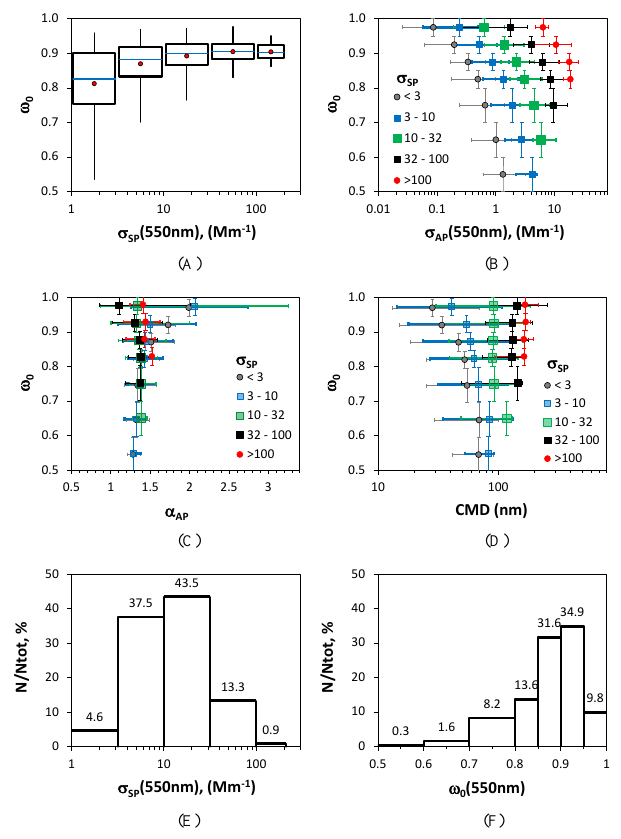
Fig. 14. Single-scattering albedo ( ω 0 ) at λ = 550nm as a function of (A) scattering coefficient ( σ SP ) , (B) absorption coefficient ( σ AP ) and σ SP , (C) ˚Angstr¨om exponent of absorption ( α AP ) and σ SP , and (D) particle size (count mean diameter); (E) the fraction of data in the σ SP bins and (F) the fraction of data in the ω 0 bins. In A the red circle is the average, the blue horizontal line the median, the box the 25th to 75thpercentile range and the vertical error bar the 2.5th to 97.5thpercentile range of ω 0 in each of the five σ SP bins. In (B) , (C) , and (D) the symbols are color-coded into the five σ SP bins, the vertical error bars represent the seven ω 0 bins, the symbol is the median and the horizontal error bars the 95% range of the respective